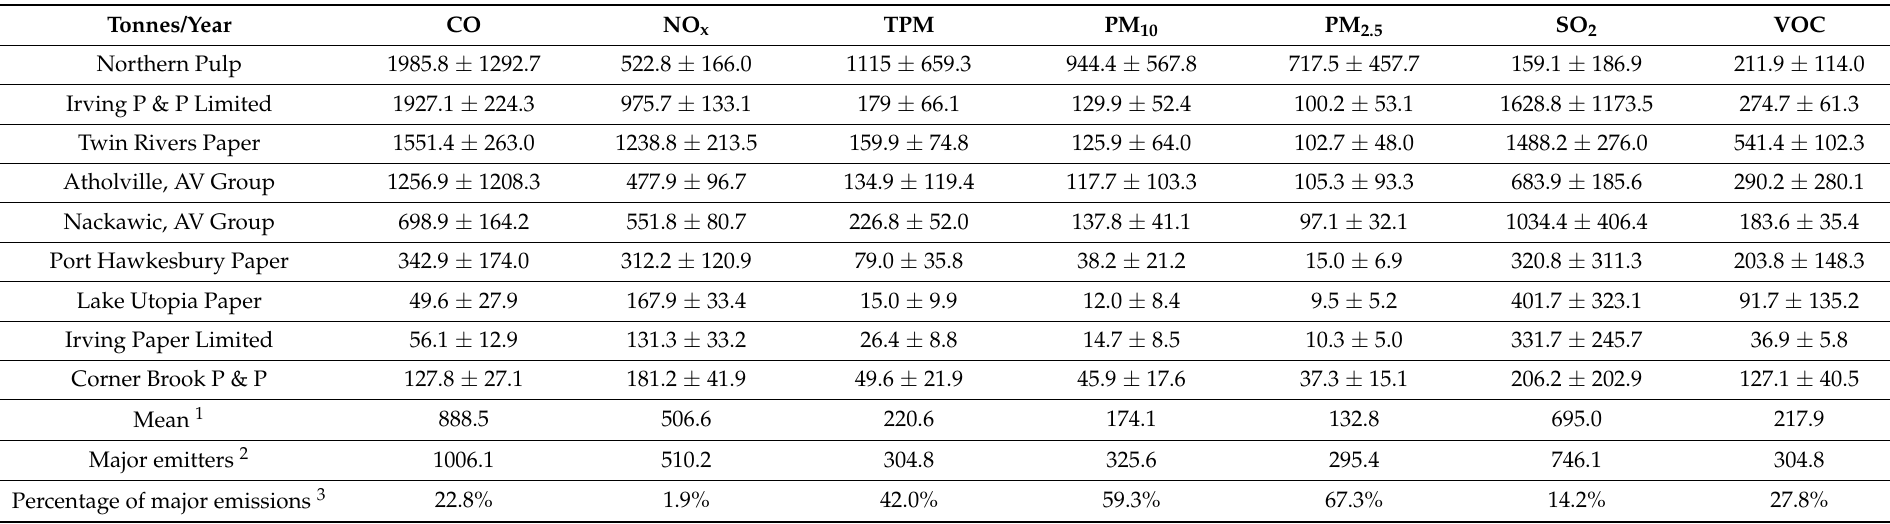
Table 5. Mean and standard deviation ( ± ) of air releases in each mill from 2002 to